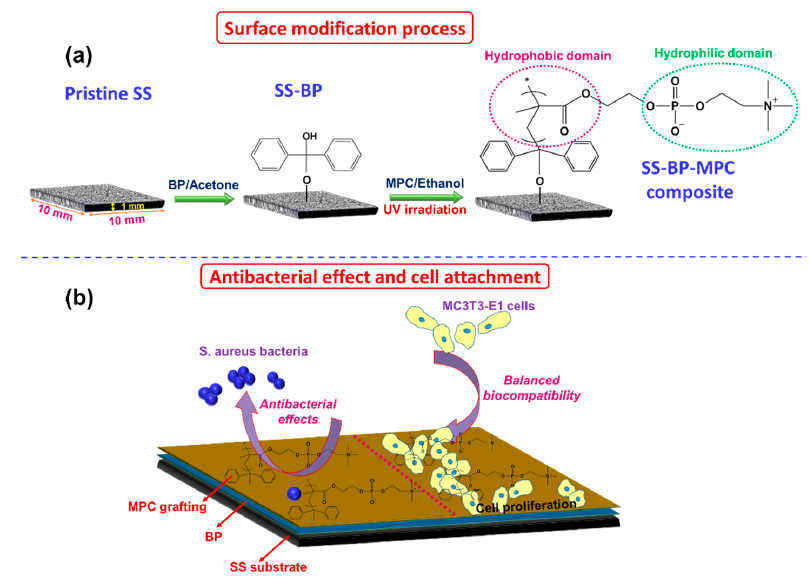
Figure 1. Schematic diagram of benzophenone and 2-methacryloyloxyethyl phosphocholine grafted stainless steel (SS-BP-MPC) composite for ( a ) surface modification process and ( b ) antibacterial effects and cell attachment effects.